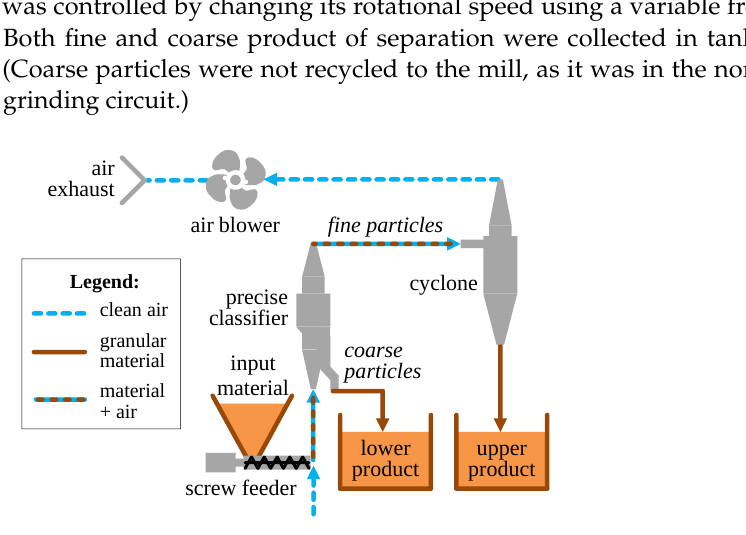
Figure 3. Experimental setup involving classification subsystem of the grinding